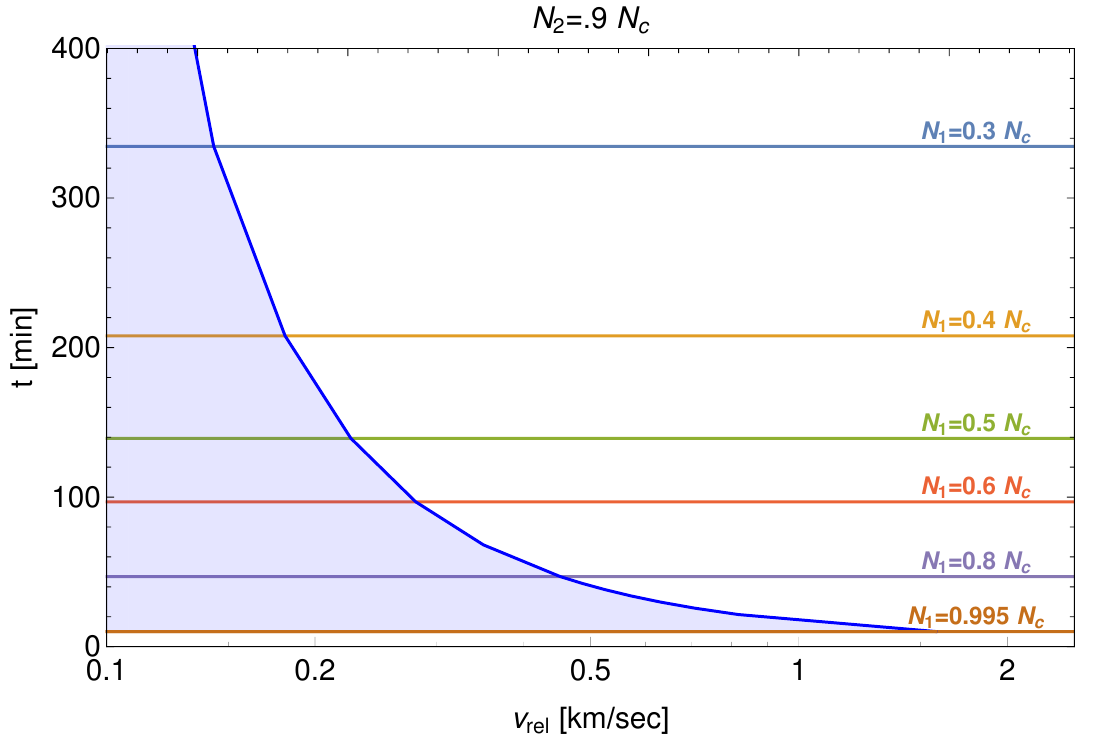
Figure 3 . The relevant timescales for the collision and possible collapse of two ASts. The horizontal lines are the required times t (cid:3) for an ASt with N 1 particles to collapse from (cid:26) (cid:3) to (cid:26) 0 it collides with a second ASt which has N 2 partices at a relative velocity v rel . The blue curve represents the approximate time t in that one ASt spends traversing the other. If t in < t (cid:3) (the blue shaded region), then the ASt